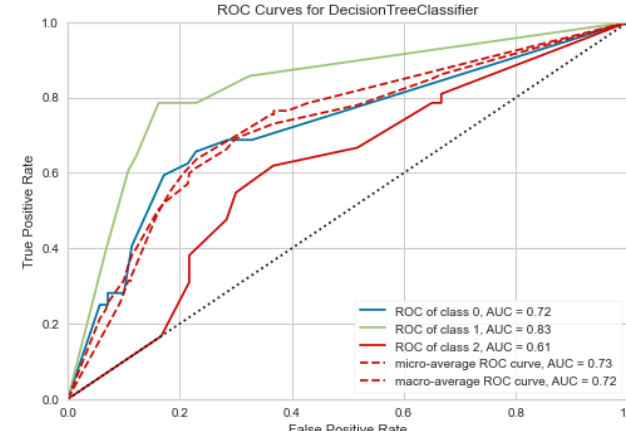
Fig. 3. MLA performance with the leave-one-out training technique.